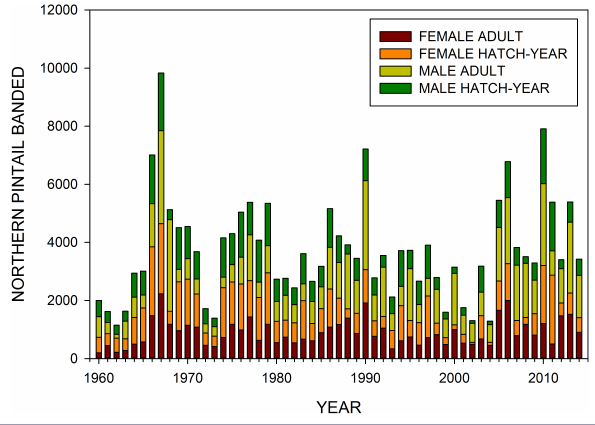
Fig. 3. Numbers of Northern Pintail ( Anas acuta ) banded in Alberta and Saskatchewan, Canada (≤ 54° N latitude) from